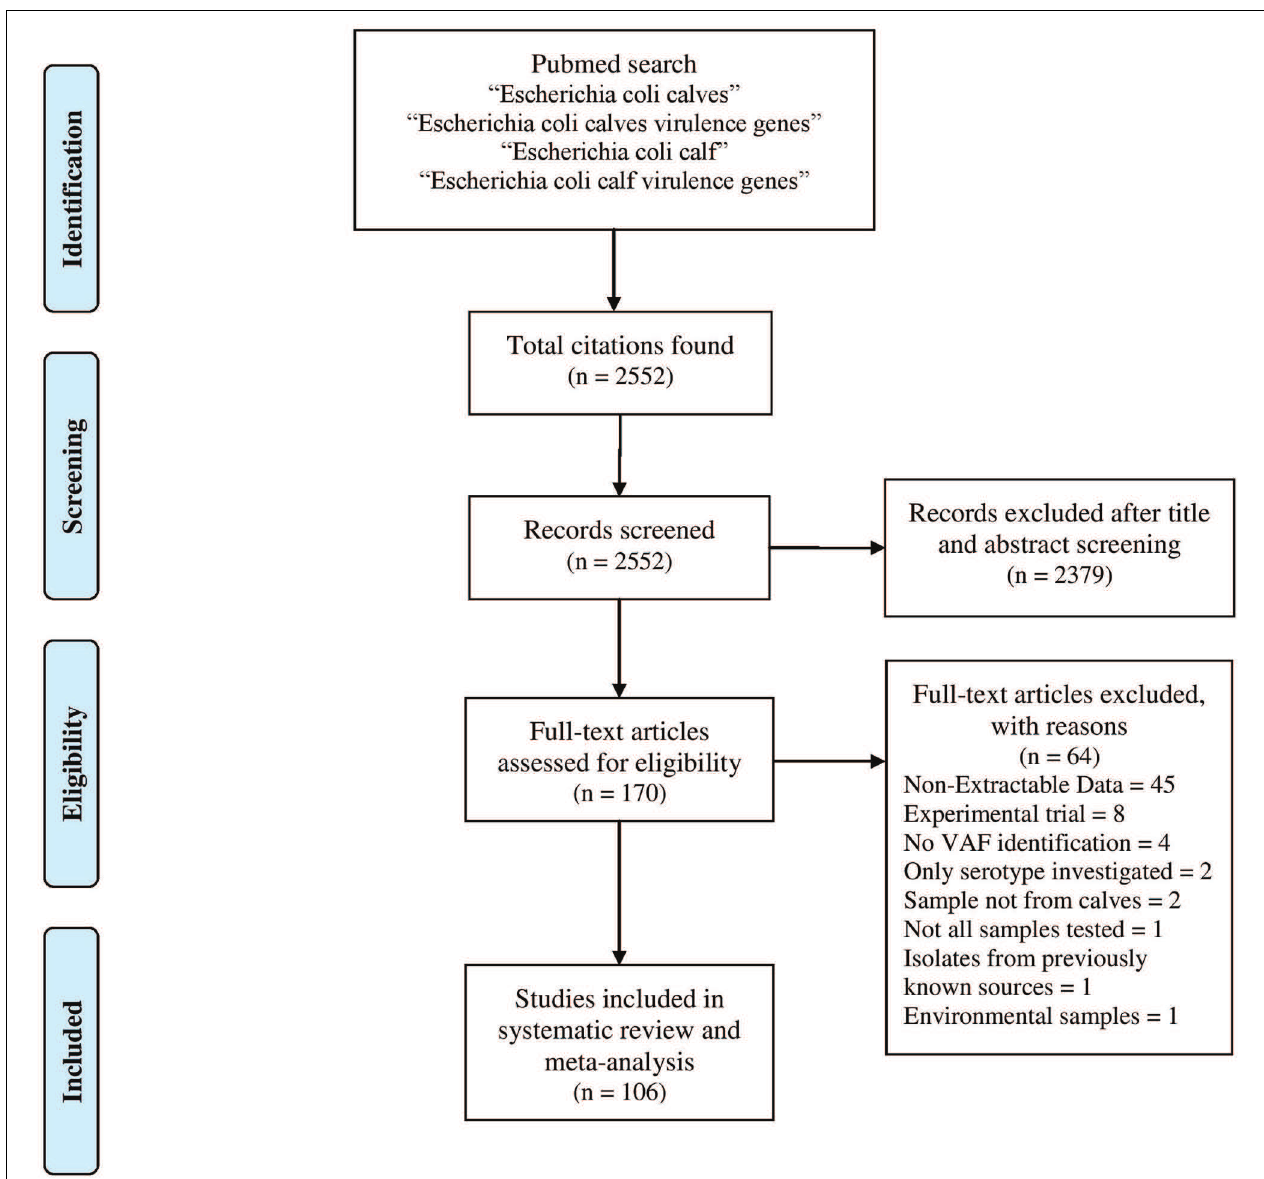
FIGURE 1 | Flow diagram for the selection of